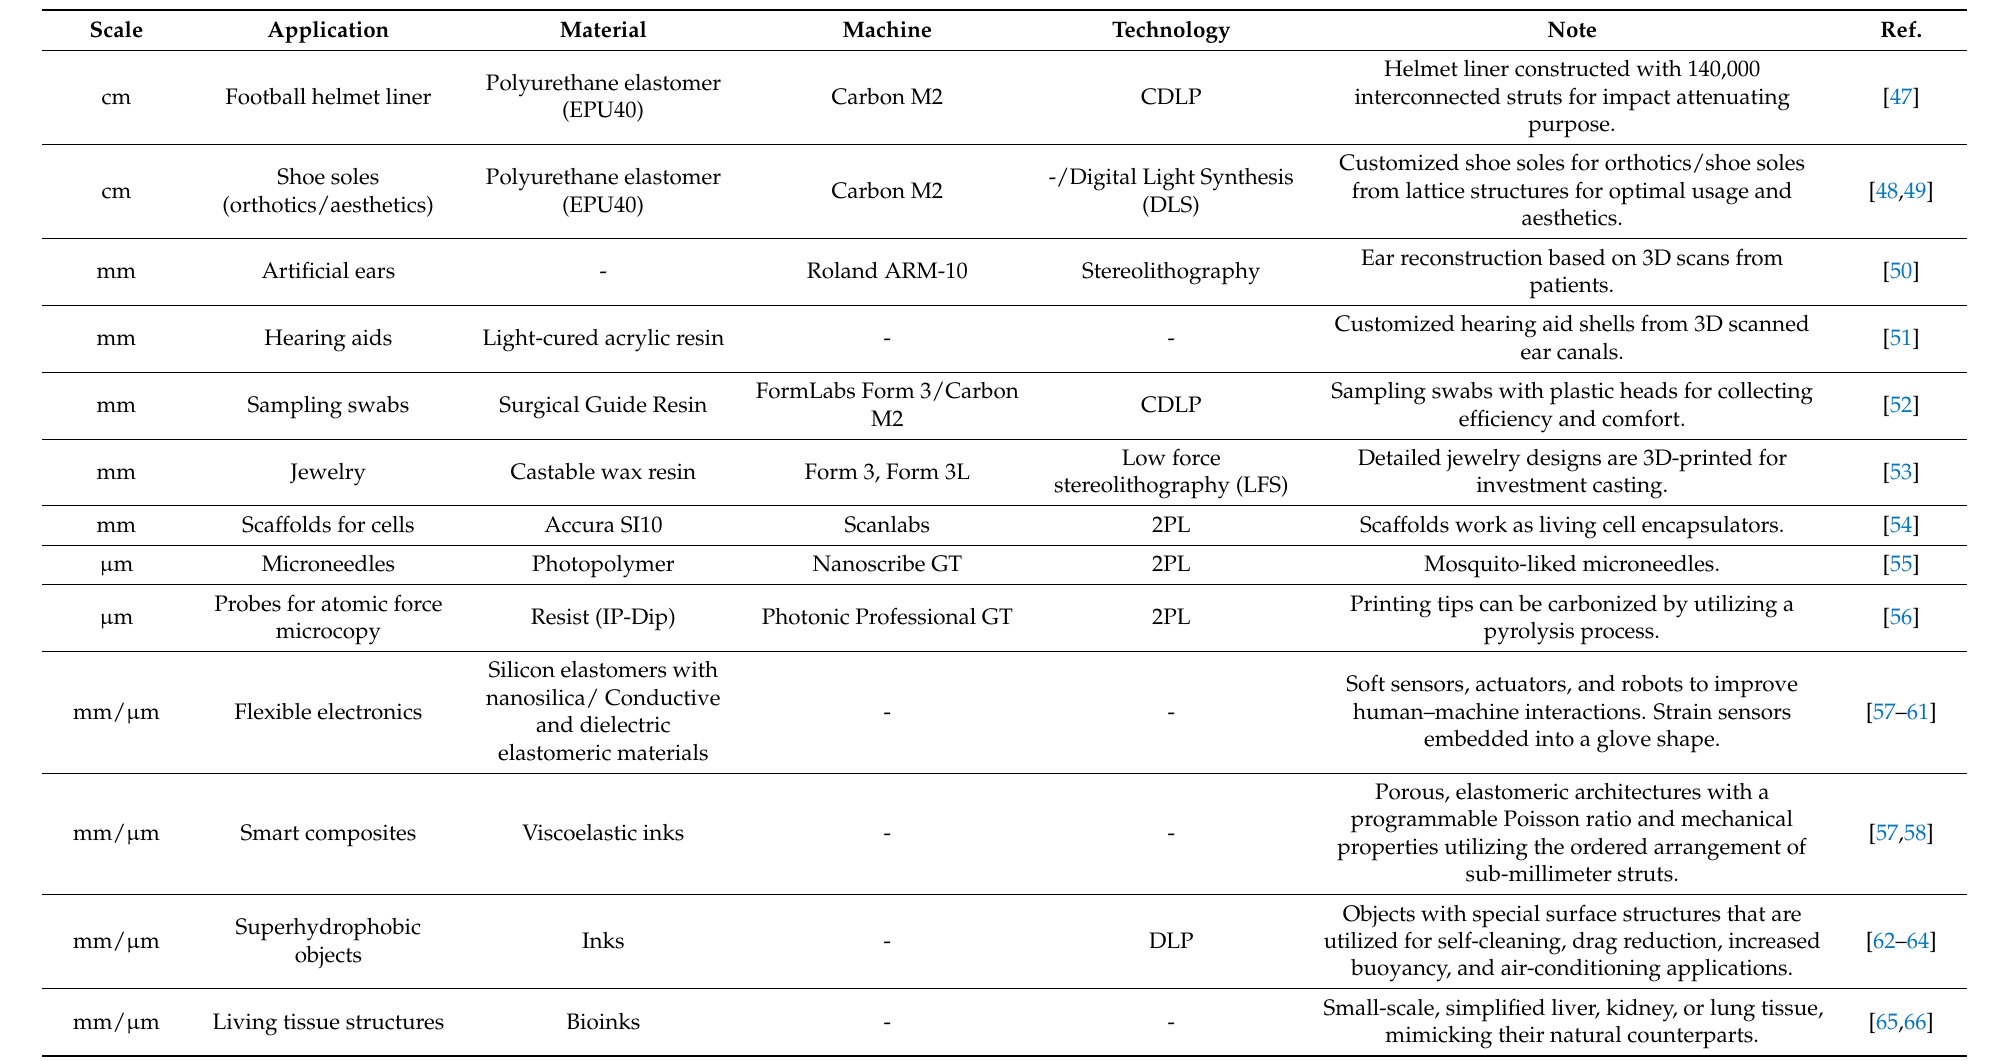
Table 7. Photopolymerization